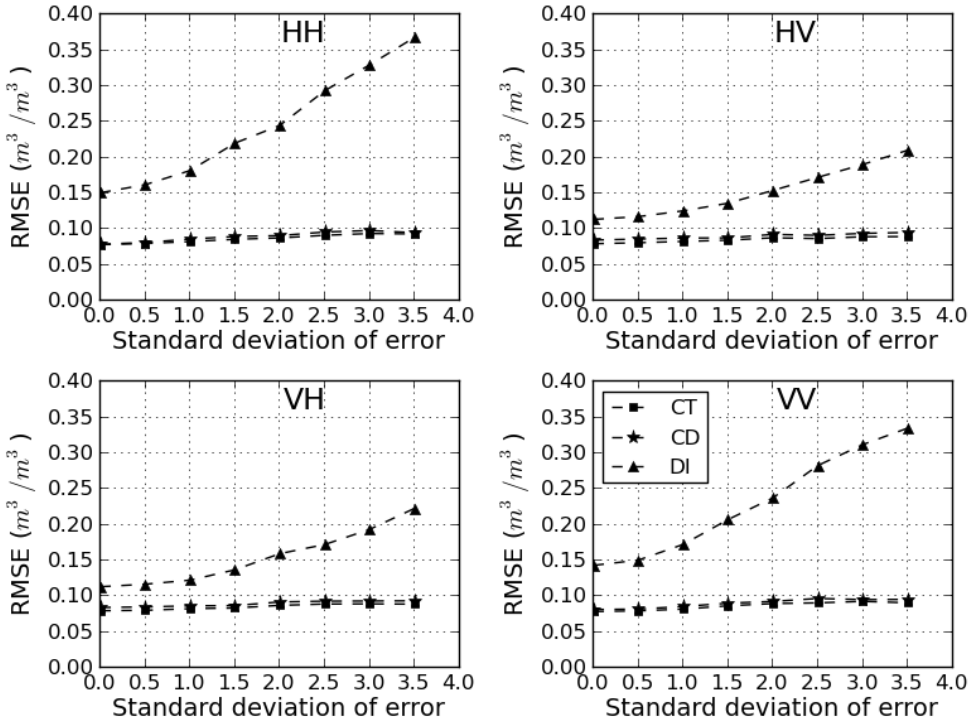
Figure 10. Effect of error in backscatter coefficient on the retrieval accuracy (CT—CDF transformation based model, CD—change detection, DI—delta